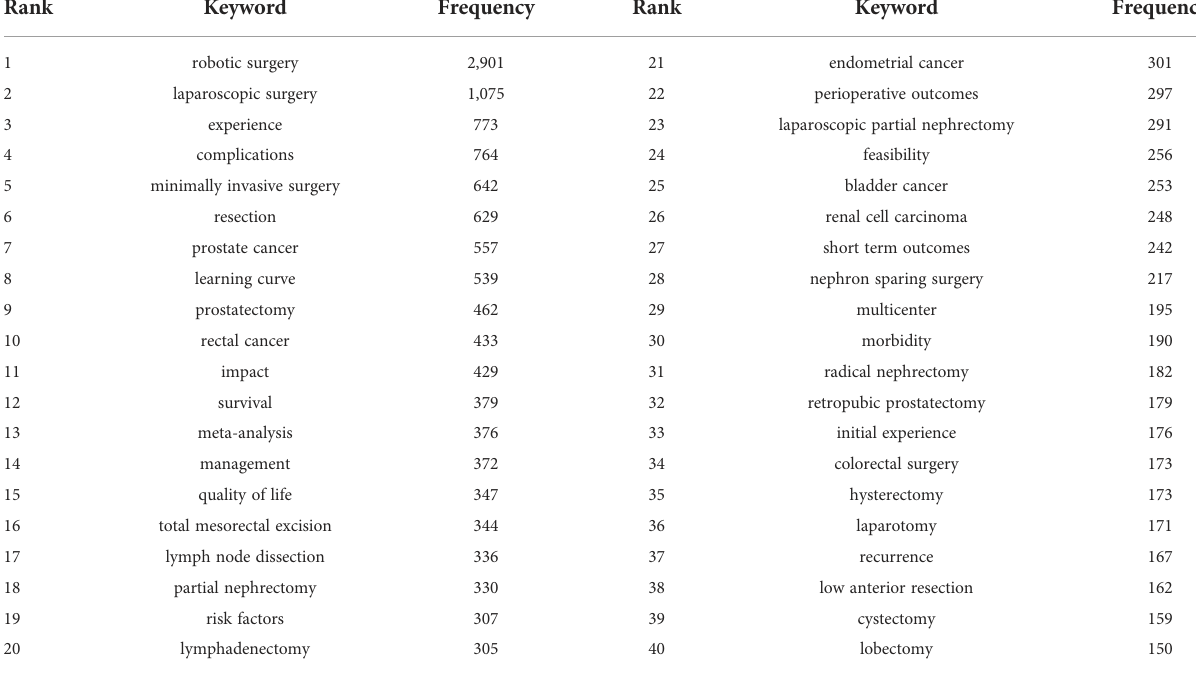
TABLE 8 The top 40 keywords in terms of frequency related to robotic surgery in oncology.